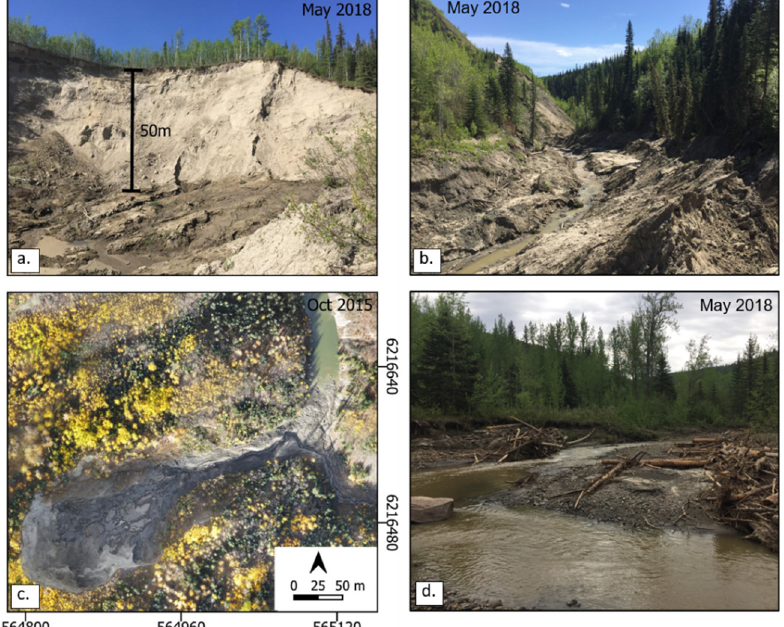
Figure 2. Overview of the Brenot Creek Landslide. ( a ) Landslide scar in 2018, ( b ) Brenot Creek downstream of the landslide in 2018, ( c ) aerial drone orthomosaic imagery of the landslide scar in 2015 showing temporary landslide dam, and ( d ) Lynx Creek in 2018. Woody debris and coarser riverbed sediment can be found on bars along the channel.